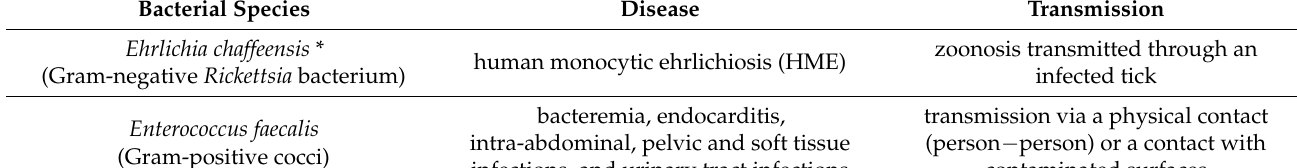
Table 1. Selected bacterial pathogens and the associated diseases in humans and animals [1,39–47]. Bacterial